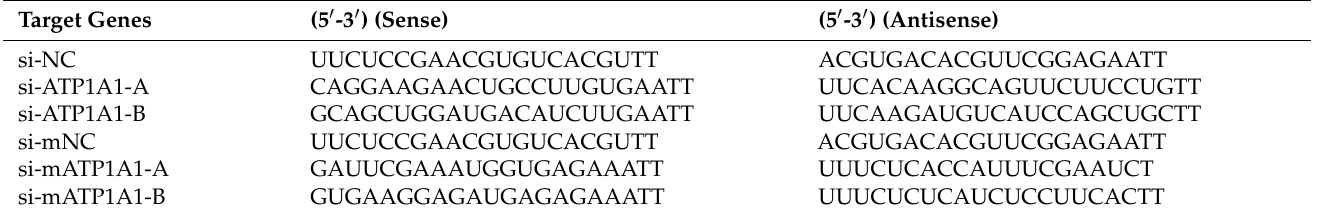
Table 2. siRNAs used in this